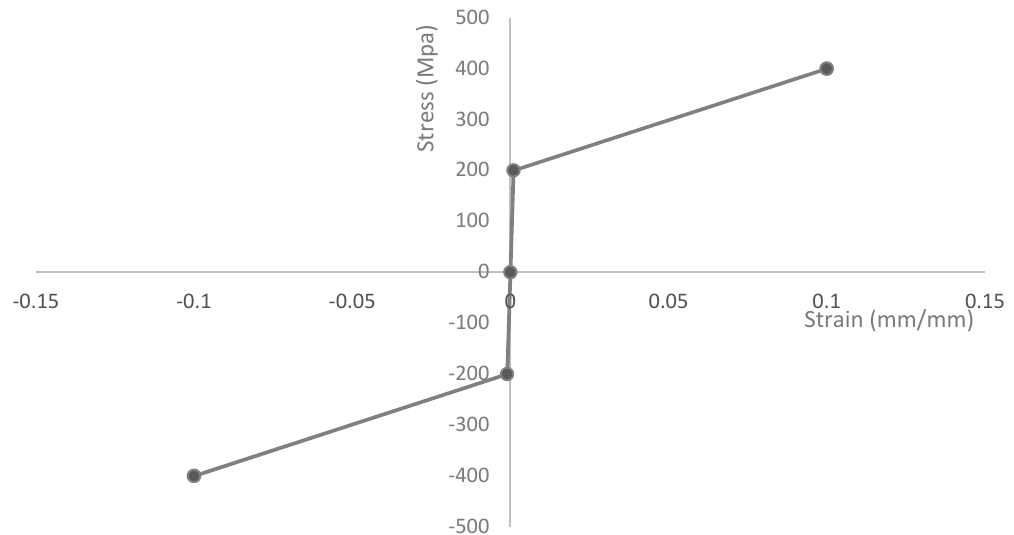
Figure 8. Detail of the stress–strain diagram of the reinforcing bars.